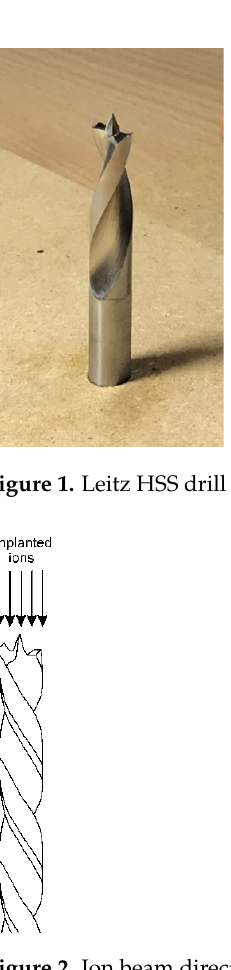
Figure 2. Ion beam direction during drill implantation.